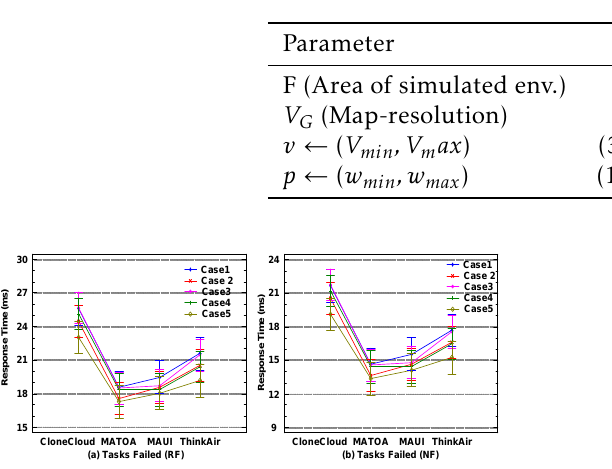
Figure 14. Adaptive Environment with respect to resource and